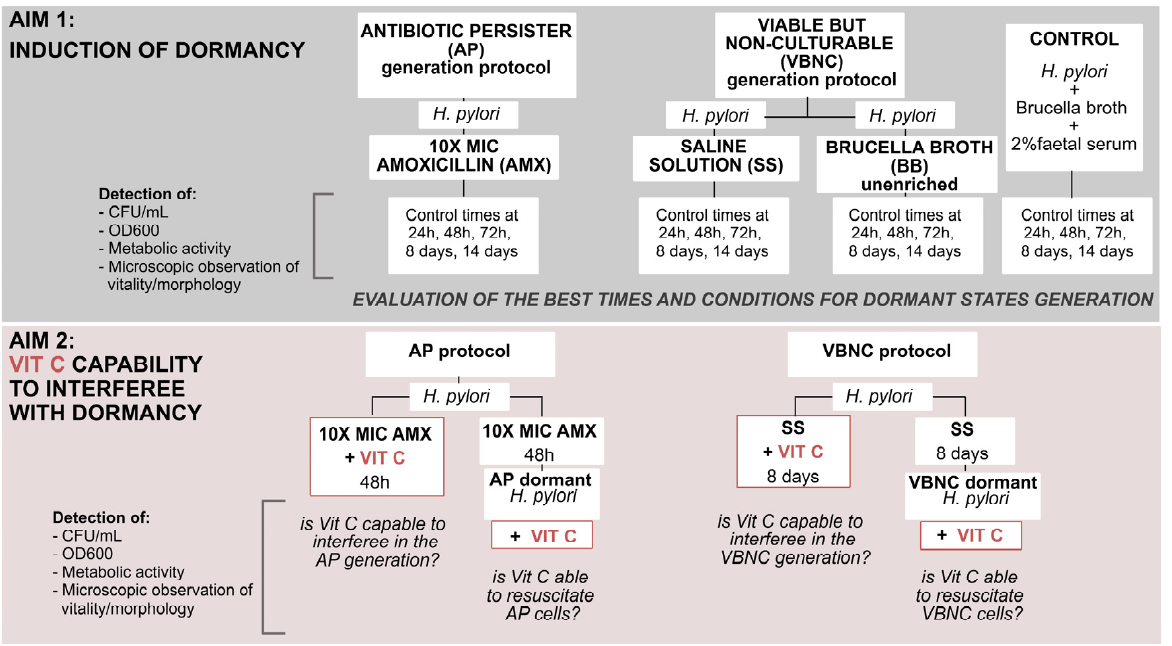
Figure 1. Study design and description of the aims of the study.